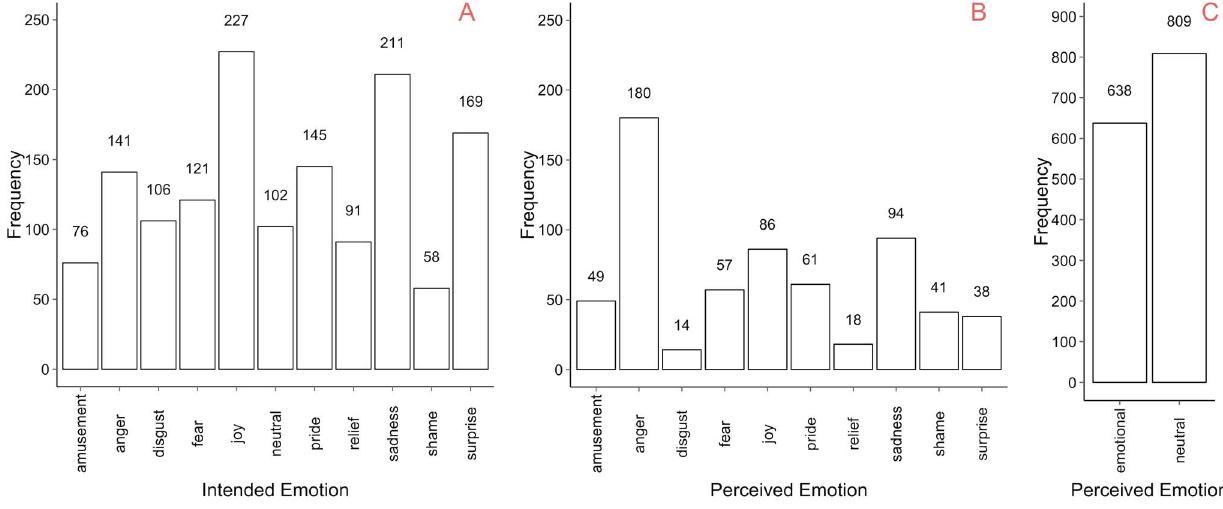
Figure 3. Motion sequence frequencies across intended (A) and perceived (B, C) emotions. Intended emotions originate from actors’ text annotations while perceived emotions come from the categories forming a unique modal value in observers’ response distribution for every motion sequence. The perceived emotion frequencies are split into two graphs to allow the same y-axis scale for (A) and (B) graphs. The emotional category in plot C is the sum of all frequencies in plot